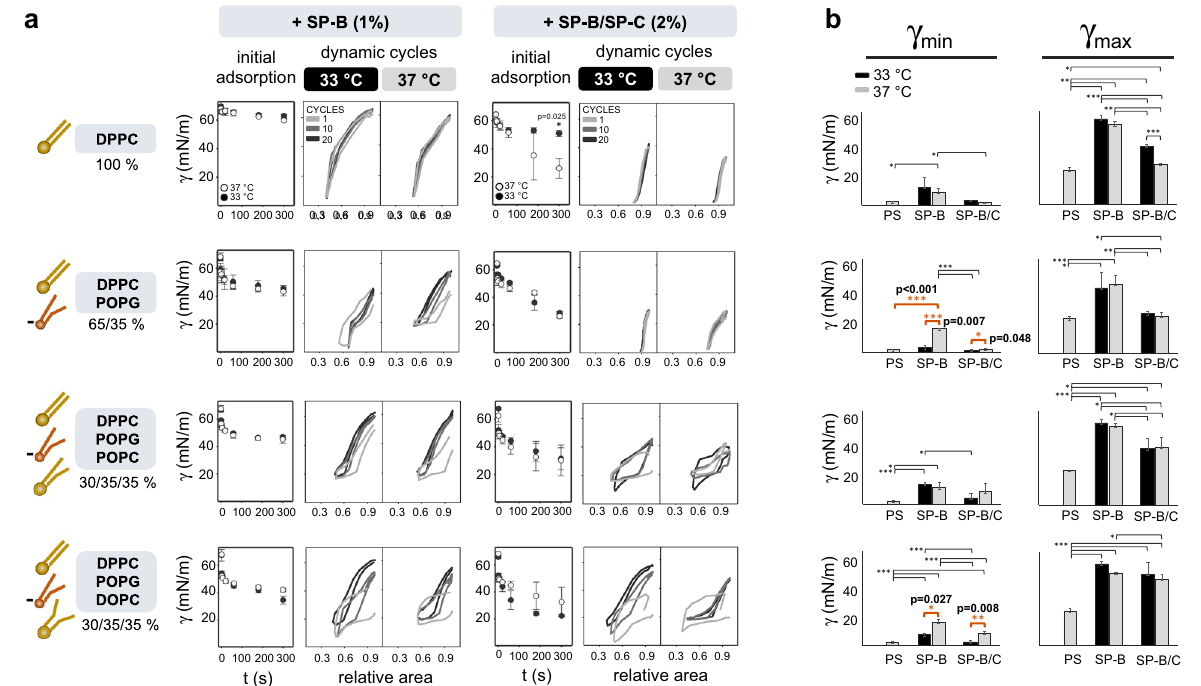
Figure 3. Contribution of lipid species and hydrophobic surfactant proteins in the temperature-mediated improvement of surfactant activity. Several surfactant lipid mixtures (DPPC, POPG, POPC and DOPC at different proportions) with decreasing capability to pack under compression were combined with purified porcine surfactant protein SP-B alone (1% w/w) or both SP-B and SP-C (2% total protein-to-lipid by weight). CBS experiments, using a concentration of 8 mg/mL of each lipid-protein mixture, were performed at 33 °C or 37 °C. ( a ) On the left, the mass percent of the lipids used in each experiment is shown. Drawings of the lipids are also shown to illustrate the different space occupied at the interface according to their unsaturation grade. Graphs of initial adsorption show means and SD of three replicates per condition. One representative replicate (n = 3) of γ-∆area isotherms under 10 quick compression-expansion cycles (20 cycles/min, 1.37 atm/s) is also shown. ( b ) Minimum and maximum surface tensions reached upon 20 dynamic cycles (n = 3), comparing each lipid–protein mixture to purified PS (8 mg/mL). Compression-expansion cycles are depicted in grey scale. Means and SD of three replicates are shown. Horizontal lines represent statistical comparisons. Paired t test = (a) γ(300 s) during initial adsorption: p = 0.025, D.F. = 2, t = − 6.2. Two-way ANOVA test followed by post-hoc test = (b) first line, γ min : temperature (n. s.) and composition (p = 0.007, D.F. = 2, F = 8.4), γ max : temperature (p < 0.001, D.F. = 1, F = 26.4) and composition (p < 0.001, D.F. = 2, F = 150.6); second line, γ min : temperature (p < 0.001, D.F. = 1, F = 258.9) and composition (p < 0.001, D.F. = 2, F = 270.3), γ max : temperature (n. s.) and composition (p < 0.001, D.F. = 2, F = 22.4); third line, γ min : temperature (n. s.) and composition (p = 0.005, D.F. = 2, F = 9.4), γ max : temperature (n. s.) and composition (p < 0.001, D.F. = 2, F = 41.1); fourth line, γ min : temperature (p < 0.001, D.F. = 2, F = 168.9) and composition (p < 0.001, D.F. = 2, F = 160.9), γ max : temperature (n. s.) and composition (p < 0.001, D.F. = 2, F = 31.5). *p < 0.05 and > 0.01, **p ≤ 0.01 and > 0.005, ***p ≤ 0.005. The exact p values of the most relevant post-hoc tests are indicated. The corresponding comparison bars and symbols are highlighted in orange color. γ surface tension, DPPC dipalmitoylphosphatidylcholine, POPG palmitoyloleoylphosphatidylglicerol, POPC palmitoyloleoylphosphatidylcholine, DOPC dioleoylphosphatidylcholine, PS purified porcine surfactant, SP-B surfactant protein B, SP-C surfactant protein C, min minimum, max maximum, n. s. not significant, D.F. degrees of upon slow cycling (2 cycles/min) at different surfactant concentrations (1.5, 2.5 and 5 mg/mL), both at 33 and 37 °C (Fig. 4a). Within each condition, no differences between temperatures in initial adsorption and γ max were noticed. Conversely, the dynamic activity (γ min ) of PS at 1.5 mg/mL was clearly impaired in the presence of plasma (Fig. 4a, second line). Interestingly, at this concentration, PS capability to produce very low surface ten- sion was reduced with and without plasma at 37 °C, but still functional in the absence of plasma at 33 °C (Fig. 4a, second line). Moreover, when PS was tested at 2.5 mg/mL it worked properly in the presence of plasma at 33 °C, but it was inactivated at 37 °C (Fig. 4a, second line). Restoration experiments (Supplementary Fig. S4) were then performed, maintaining the same amount of plasma, but using different concentrations of PS depending on the experimental temperature: 1.5 mg/mL at 33 °C and 2.5 mg/mL at 37 °C. The restoration activities of two different materials were studied under these condi- tions: (1) Poractant α (PORα), a widely used therapeutic surfactant, and (2) DPPC/POPG (65/35, w/w) + SP-B/ SP-C (2% total protein-to-lipid by weight), the lipid-protein mixture that had shown the best surface-activity (comparable to PS). Several amounts of these materials were used to mimic a therapy, by adding small volumes at increasing concentrations on top of plasma-inhibited surfactant (Supplementary Table S2, Fig. S4) until reaching